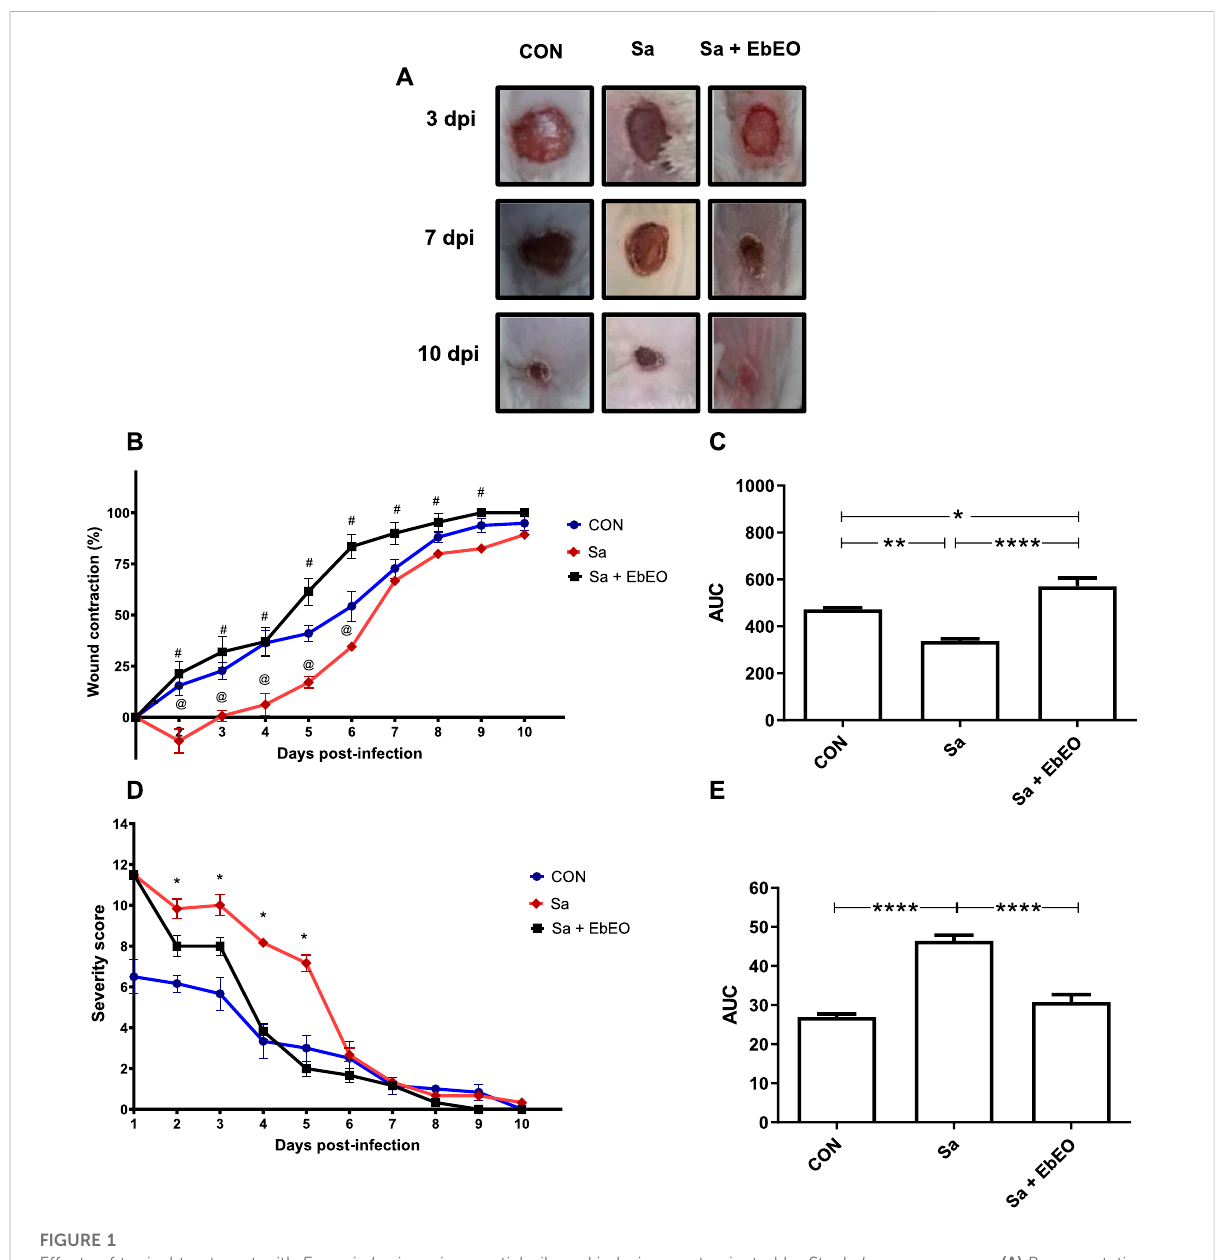
FIGURE 1 Effects of topical treatment with Eugenia brejoensis essential oil on skin lesion contaminated by Staphylococcus aureus . (A) Representative images of wounds contraction evolution; (B) Relative wound contraction values obtained during the 10 days of analysis; (C) Area under curve (AUC) ofdata obtained from wound contraction; (D) Analysisofthe clinical parameters of theexperimentalgroups during theclinical evaluation period. (E) Analysis of the area under the curve (AUC) of the clinical parameters of the mice. (@) Statistical differences of PBS-treated infected wound area (Sa group) and other experimental groups (CON and Sa + Cramoll groups) ( p < 0.001); (#) Statistical differences of PBS-treated infected wound area (Sa group) and Cramoll-treated infected wounds (Sa + Cramoll group) ( p < 0.01). * p < 0.05; ** p < 0.01; *** p < 0.001; *** p <